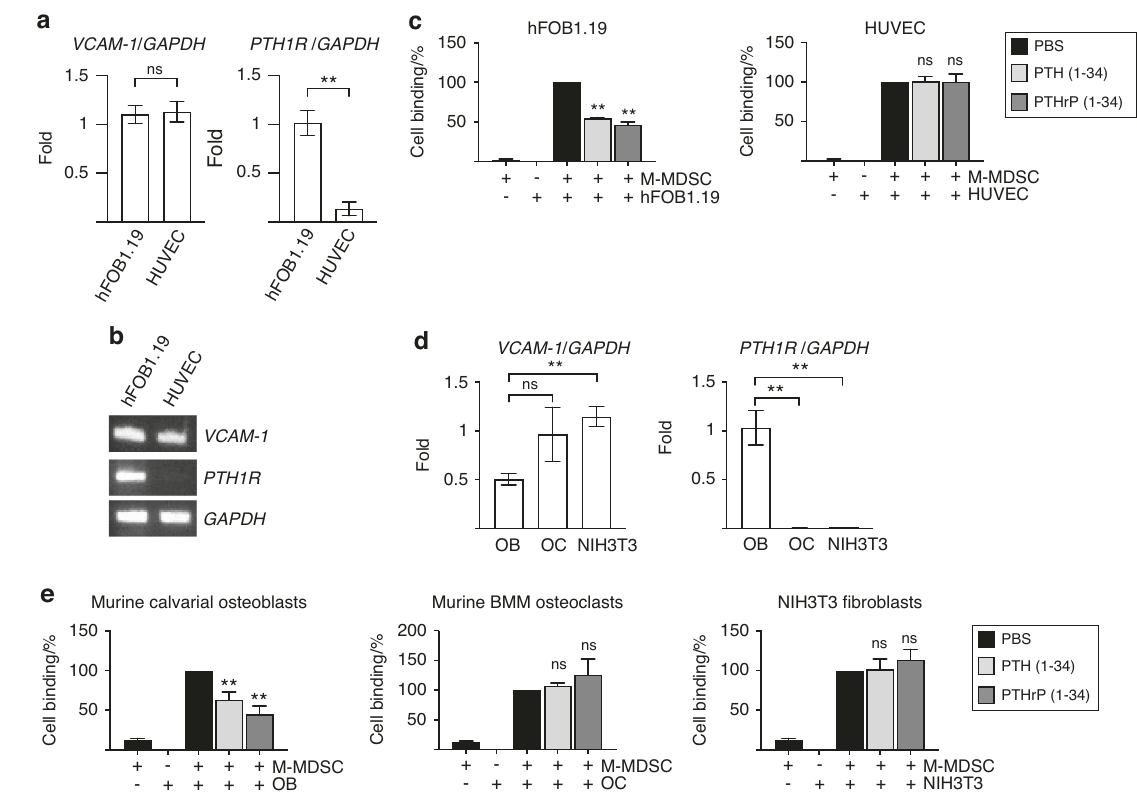
Fig. 5 Binding between M-MDSCs and bone marrow stromal cells is dependent on VCAM1 expression, but PTH1R ligand (PTH or PTHrP)- induced release is dependent on PTH1R expression. a , b Expression of VCAM1 and PTH1R in hFOB1.19 (human osteoblasts) and HUVECs (human umbilical vein endothelial cells) analyzed by quantitative ( a ) and semiquantitative ( b ) RT ‒ PCR. Both hFOB1.19 cells and HUVECs expressed VCAM1, but only hFOB1.19 cells expressed PTH1R. Data are the mean ± SEM ( n = 3 per group). ** P < 0.01, one-way ANOVA with multiple group comparisons. NS, nonsigni fi cant. c In vitro cell binding assay showing that rhPTH(1-34) or rhPTHrP(1-34) released M-MDSC binding to osteoblasts in hFOB1.19 cells, but not in HUVECs, compared with the PBS control. M-MDSCs were isolated from 4T1 tumor-bearing murine tibiae by fl ow cytometric sorting. d Expression of VCAM1 and PTH1R in murine calvarial osteoblasts (OB), murine bone marrow monocyte (BMM)-derived osteoclasts (OC) and NIH3T3 murine fi broblasts analyzed by quantitative RT ‒ PCR. OB, OC and NIH3T3 cells expressed VCAM1, but only OB cells expressed PTH1R. Data are the mean ± SEM ( n = 3 per group). ** P < 0.01, Student ’ s t test. NS nonsigni fi cant. e In vitro cell binding assay showing that rhPTH (1-34, 10 nmol·L − 1 ) or rhPTHrP (1-34, 10 nmol·L − 1 ) released M-MDSC binding to osteoblasts in OBs but not in OCs or NIH3T3 cells compared with the PBS control. M-MDSCs were isolated from 4T1 tumor-bearing murine tibiae by fl ow cytometric sorting. Data are the mean ± SEM ( n = 3 per group). * P < 0.05, ** P < 0.01, one-way ANOVA with multiple group comparisons. NS nonsigni fi